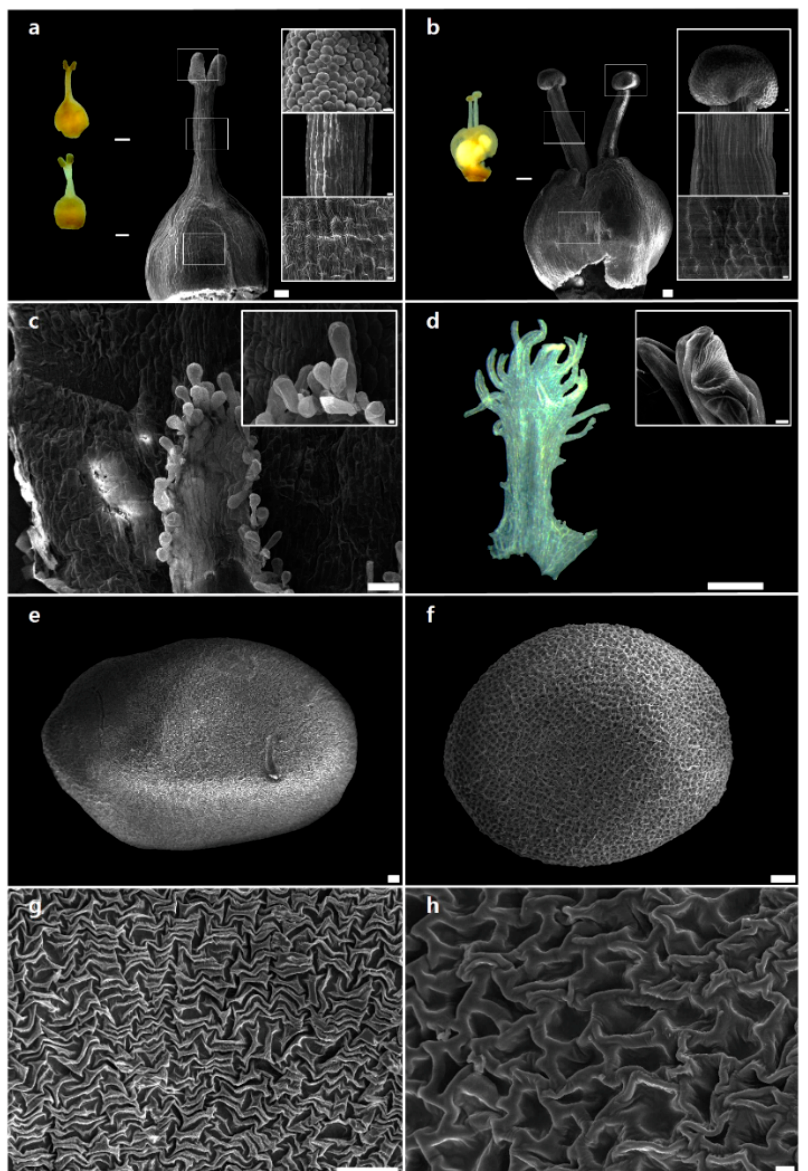
Figure 1. Scanning electron microscope (SEM) and light microscope (LM) micrographs showing the morphology of the major reproductive organs of Cuscuta japonica and C. chinensis . ( a ) Gynoecium with one style. Small LM micrographs show cylindrical and ellipsoid stigmata (left). SEM micrographs at a higher resolution (right) show cylindrical stigma with papillate cells (top), style with striate cells (middle) and ovary with papillate cells (bottom). ( b ) Gynoecium with two (equal and unequal) styles. Small LM micrographs show unequal styles (left). SEM micrographs at a higher resolution (right) show capitate stigma with papillate cells (top), style with striate cells (middle) and ovary with papillate cells (bottom). Scale bars: 100 µ m ( a , b ); 1 mm (small LM micrographs of a,b); 10 µ m (small SEM micrographs of a,b). ( c ) Fimbriae of infrastaminal scale (IFS). Inset shows IFS with glandular trichomes. ( d ) IFS. Inset shows IFS with secretory cells (internal laticifers). Scale bars: 100 µ m ( c , d ); 10 µ m (small SEM micrographs of c,d). ( e ) Pyriform to oblate seed shape. ( f ) Globose to obovoid seed shape. ( g ) Rugulate (puzzle-like) testa ornamentation. ( h ) Reticulate (net-like) testa ornamentation. Scale bars: 100 µ m ( e – g ); 10 µ m ( h ). ( a , c , e , g ) C. japonica . ( b , d , f , h ) C. chinensis .